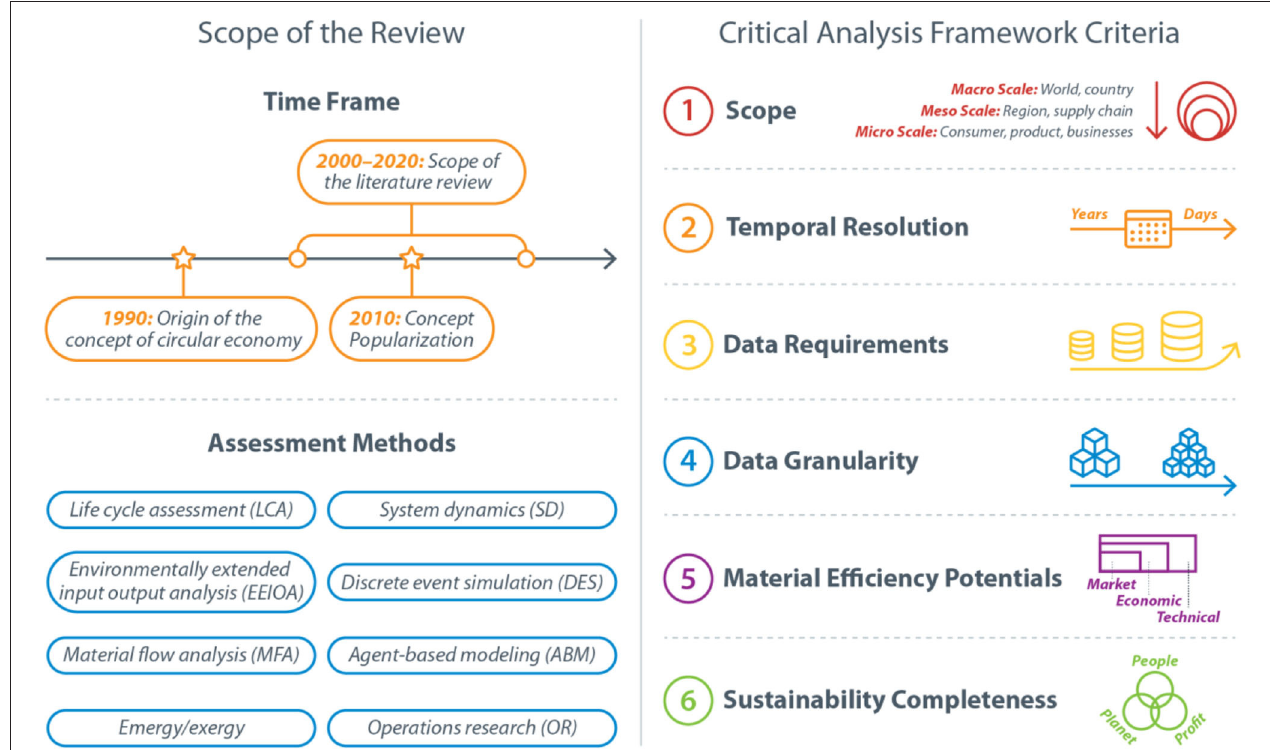
FIGURE 1 | Scope of the literature review and critical analysis framework. The publication years of the articles in the review span from 2000 to 2020 and the articles reviewed focus primarily on assessment methods used in industrial ecology and complex systems science. The methods are analyzed according to six criteria, which affect the type of research questions that may be